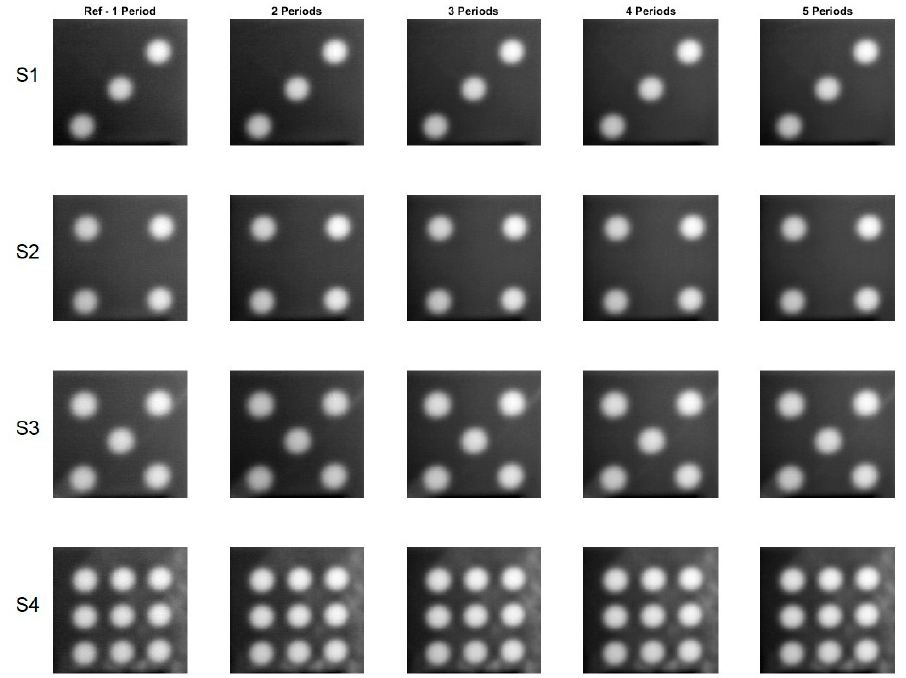
Figure 4. Flash lamp input and output signal. 5.1. Lock-In Thermography Using Flash Lamp Defects Placed 1 mm under the Measured Surface Figures 5 and 6 display phase images calculated for all eight samples for one to five periods. The reference phase images were calculated using data from a 2-min record, whereas the phase image for five periods was calculated using data from a 10-min record.